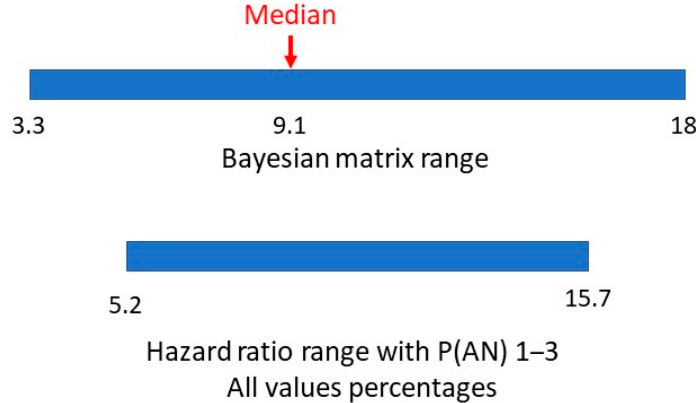
Figure 7. Bayesian matrix and hazard ratio ranges of P(AN|ASD).